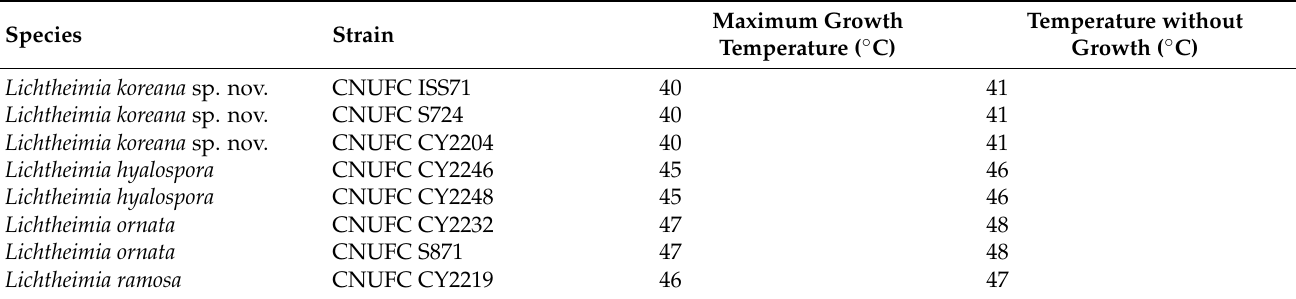
Table 2. Species tested and maximum temperature growth on MEA, PDA and